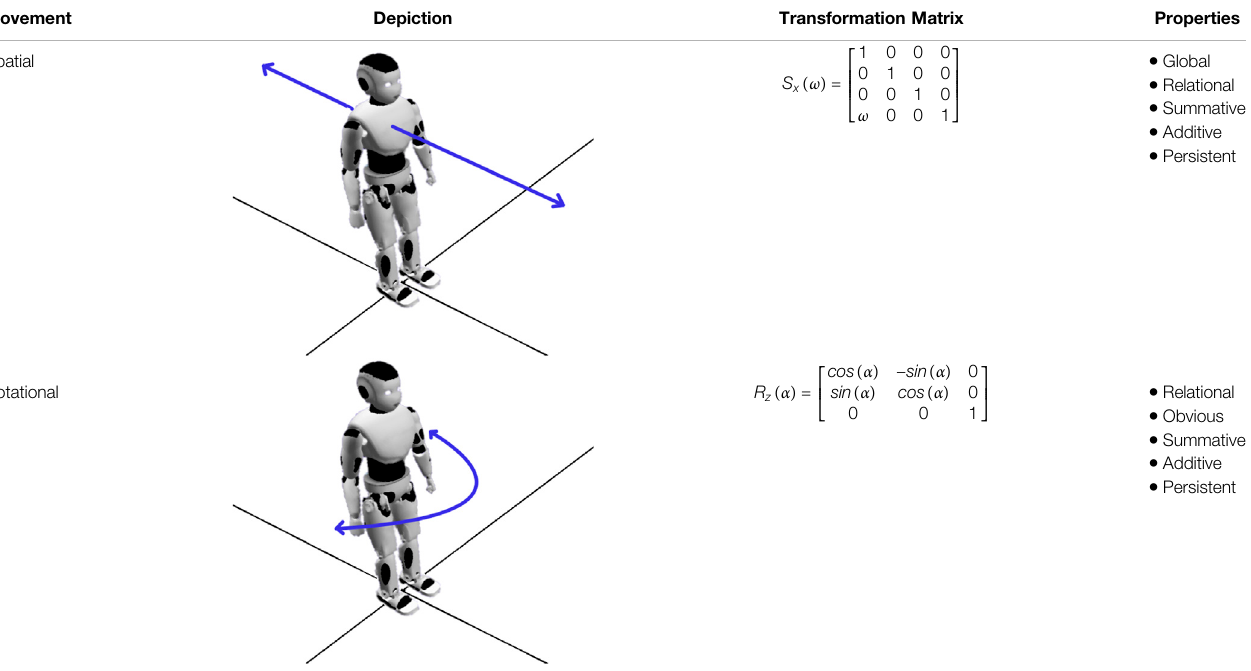
by the head or gaze direction of the robot (Clair et al., 2011). As